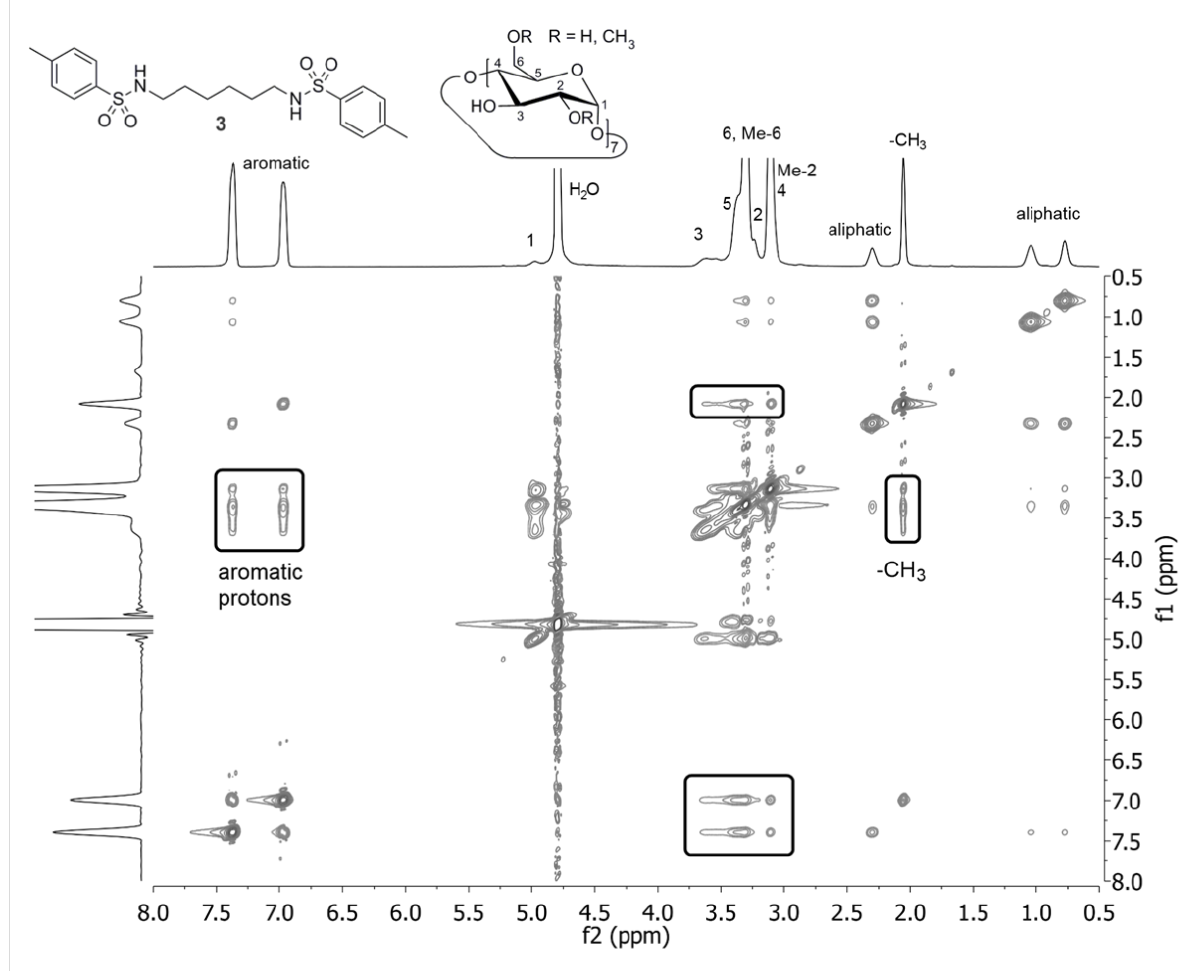
Figure 1: 2D NMR ROESY spectrum of the complex of 3 with β -CD in D 2 O, displaying the interaction of the tosyl protons with the β -CD protons.